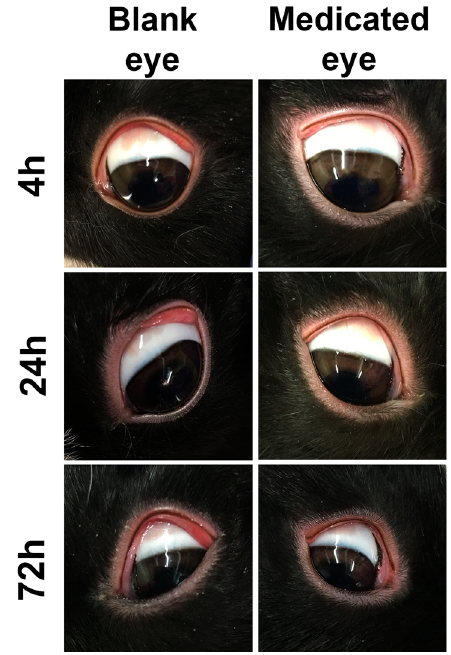
Figure 5. Photographs of Dutch belted rabbits’ eyes after 4 h, 24 h and 72 h of a single topical application of 100 μ L blank or ribavirin-loaded Carbopol 981 MEs. There is no any sign of irritation, inflammation, toxicity or allergy.